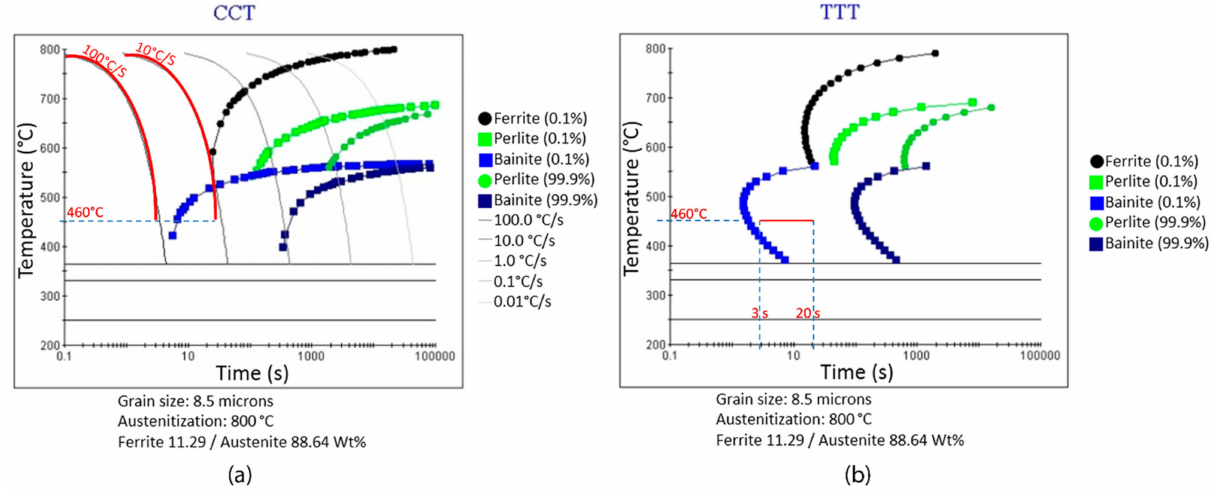
Figure 5. Phase transformation diagrams calculated by using JMatPro software. ( a ) Continuous cooling transformation (CCT) diagram and ( b ) time-temperature-transformation (TTT)